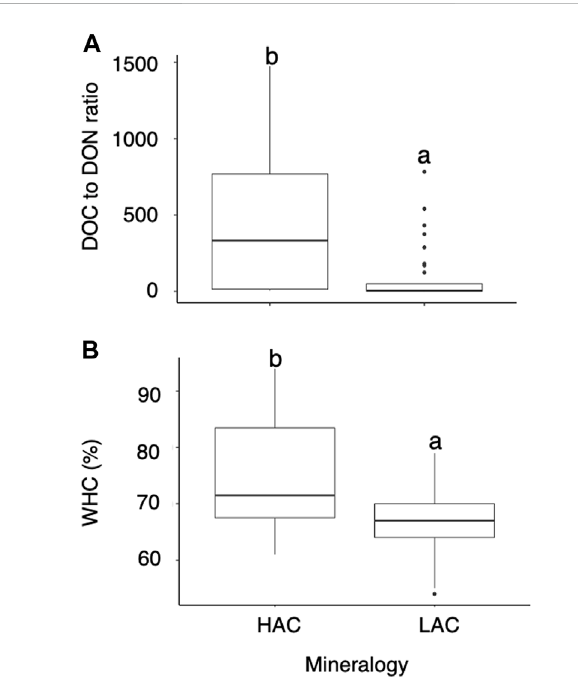
FIGURE 6 Boxplots for the proposed key indicators of health (DOC to DON ratio, (A) and WHC, (B) ) for a subset of high (HAC) and low activity clay (LAC) soils averaged across land use classes. Means sharing a letter are not signi fi cantly different (Tukey-adjusted comparison of least square means at p-value < .05.) n = 51.